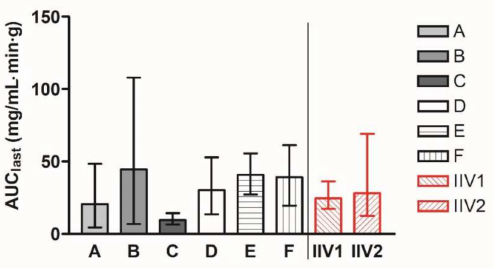
Figure 1. Geometric mean AUC last (90% CI) of individual parallel groups A–F within the program with abiraterone acetate reference product in fasted state. To the right of the division line, AUC last values of group IIV are presented for periods 1 and 2 separately.